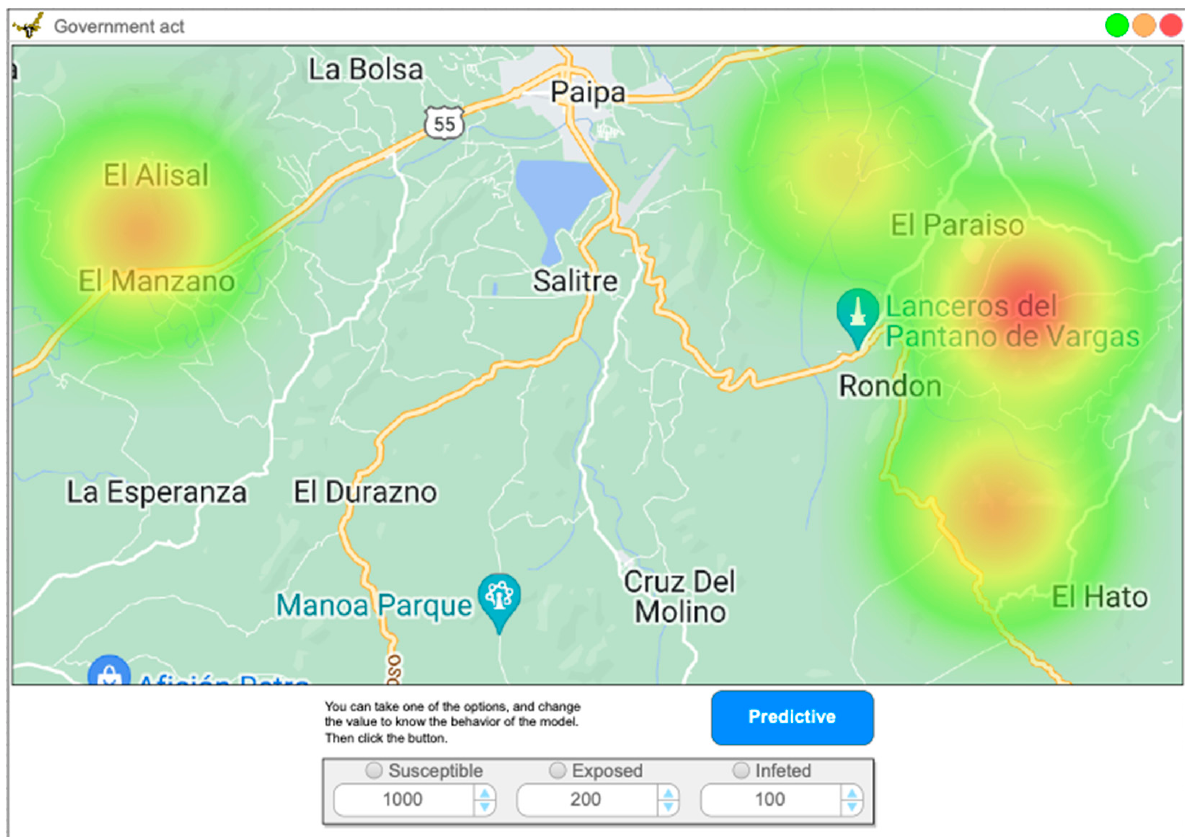
Figure 4. Government user information presentation module.